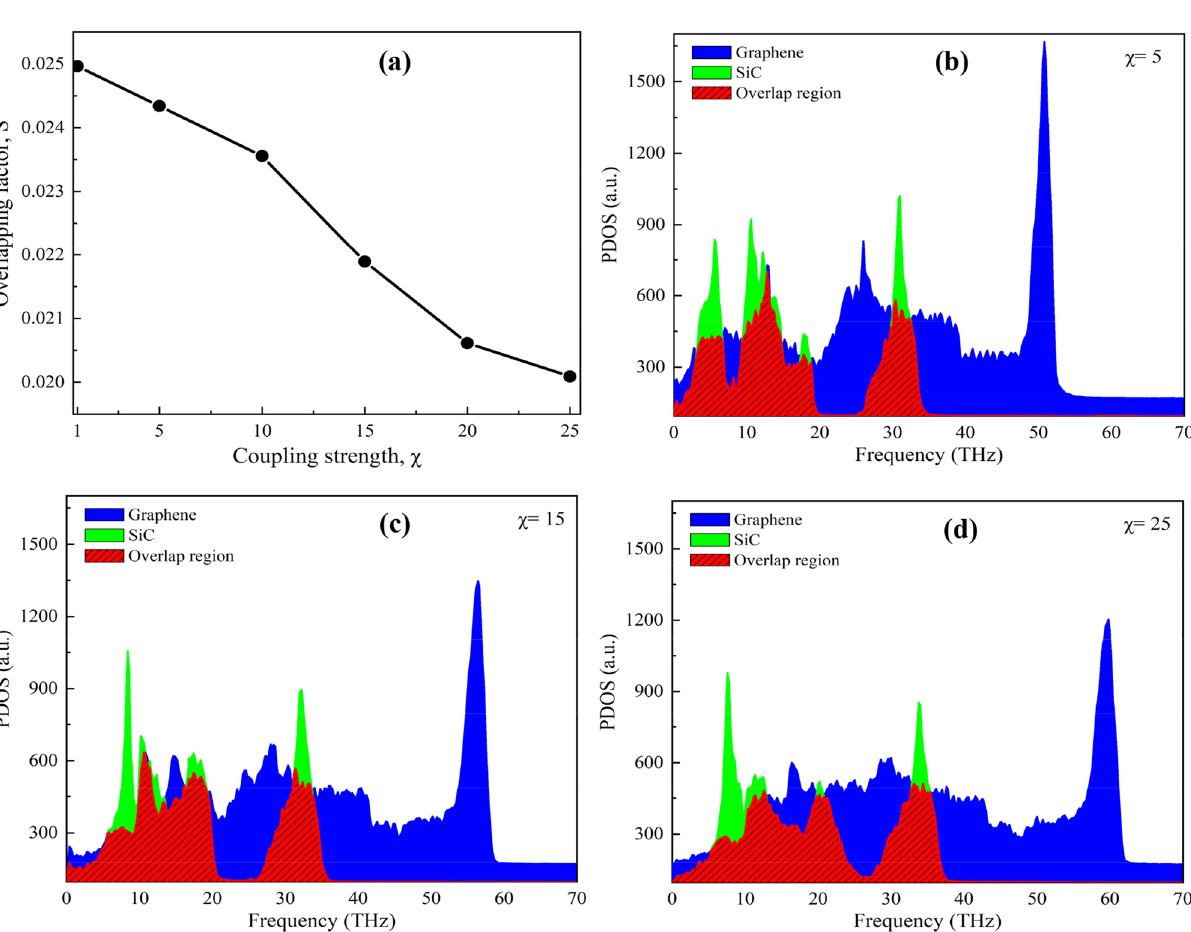
Figure 9. ( a ) Calculated overlap factor S as a function of interlayer coupling strength χ . ( b )–( d ) Overlapping region of PDOS between graphene and 2D-SiC as a function of χ . The slant areas (red) denote the overlap region between graphene and 2D-SiC